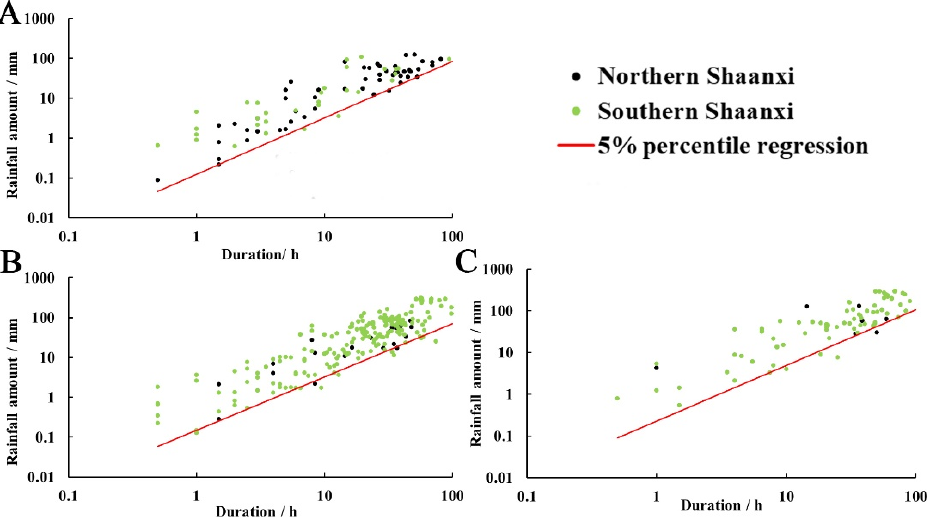
Figure 9. E-D Rainfall threshold for collapse ( A ), landslide ( B ) and debris flow( C ). Additionally, we compared the change in rainfall thresholds before and after the Wenchuan earthquake in HZ and BJ. Due to data limitations, we only established the rainfall threshold curve for landslide events. As shown in Figure 10, the pre- and post-earthquake data shared the same 5% percentile regression line, which indicated that the Wenchuan earthquake had no clear effect on the hazards of Shaanxi province except for the date of 12 May 2018 (Figure 10).